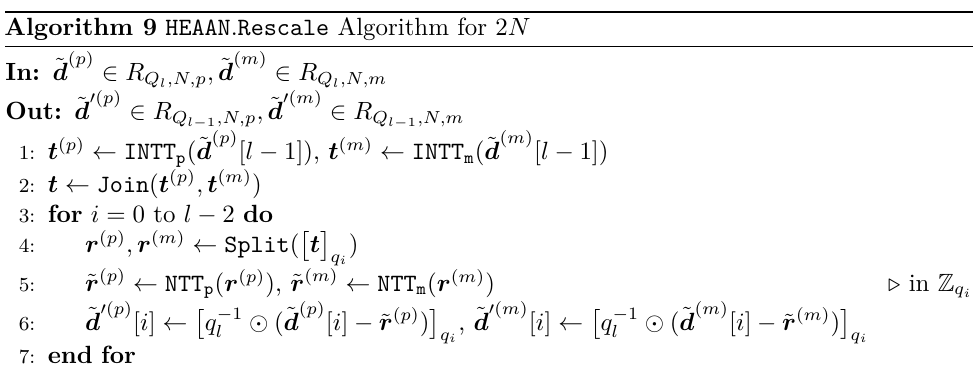
Algorithm 9 HEAAN . Rescale Algorithm for 2